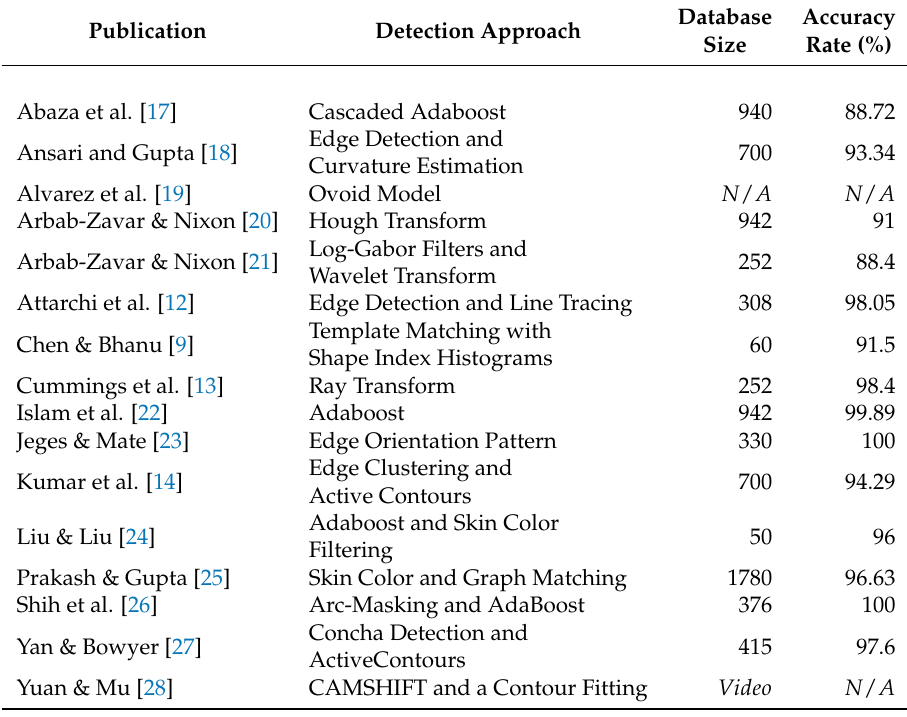
Table 1. Existing ear detection